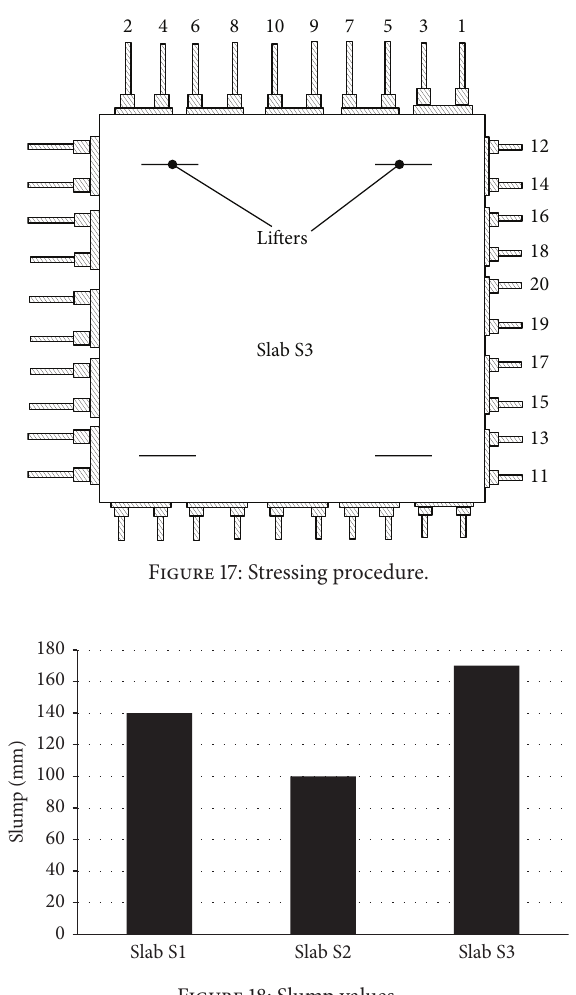
Figure 18: Slump values.